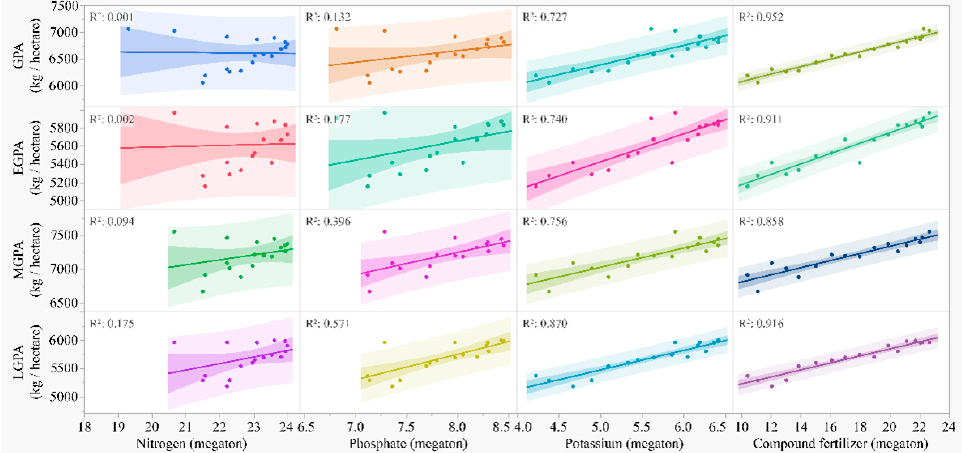
Figure 7. Grain yield per unit area (GPA) in total, early (EGPA), middle (MGPA), and late rice (LGPA) in the recent 20 years against different types of fertilizer (nitrogen, phosphate, potassium, and compound) used by the whole agricultural production in the country. Prediction andR-squares are from the polynomial regression model.